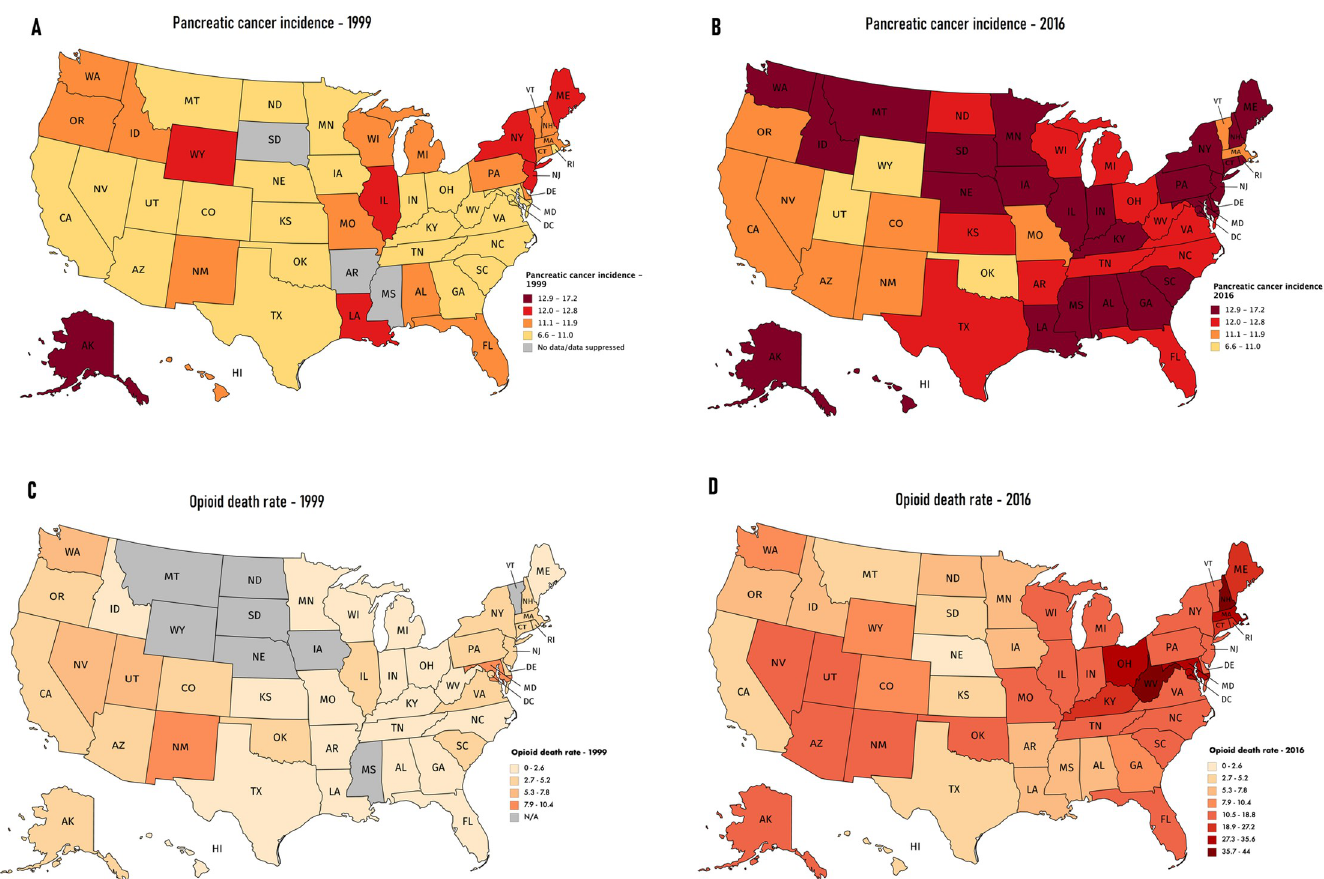
Fig 1. Incidence of pancreatic cancer (1999 and 2016), U.S Cancer Statistics Working group, and opioid death rate by state (1999 and 2016), CDC Wonder database (A) Pancreatic cancer incidence visualization by state in 1999, (B) Pancreatic cancer incidence visualization by state in 2016(C) Opioid death rate visualization by state in 1999, (D) Opioid death rate visualization by state in 2016, Reprinted from [MapChart.net] under a CC BY license, with permission from [Minas Giannekas], original copyright